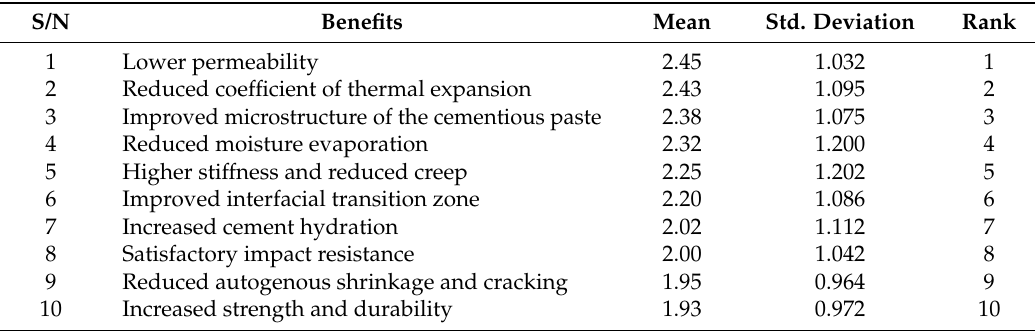
Table 2. Benefits derived from self-curing techniques in construction